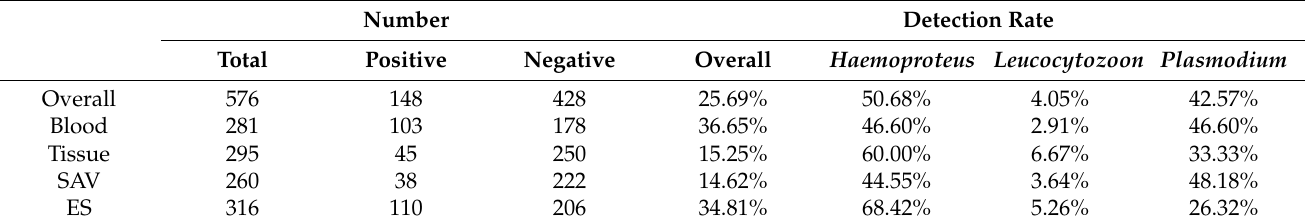
Table 1. Prevalence and detection rates for data from El Sauz (ES) and San Antonio Viejo (SAV) from 2013 to 2015, as well as each broad category of analysis, including overall, sample material, and sample locality.